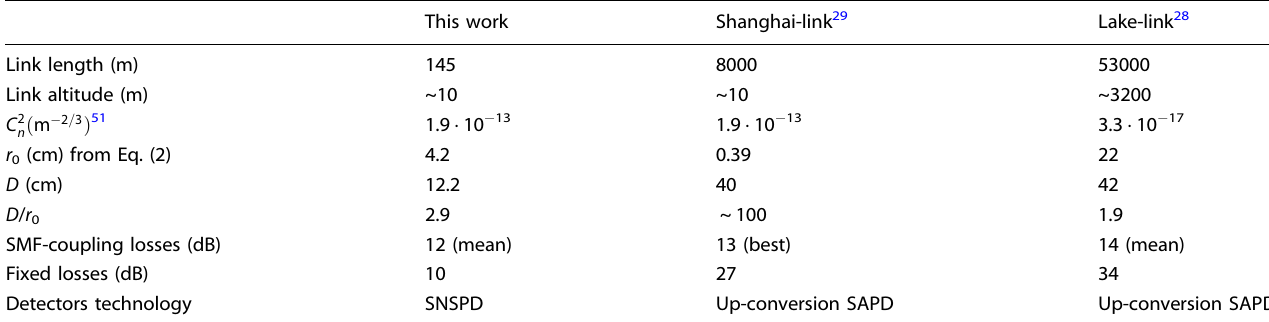
Table 1. Parameters used to compare our work with refs. 28,29 . SAPD: silicon avalanche